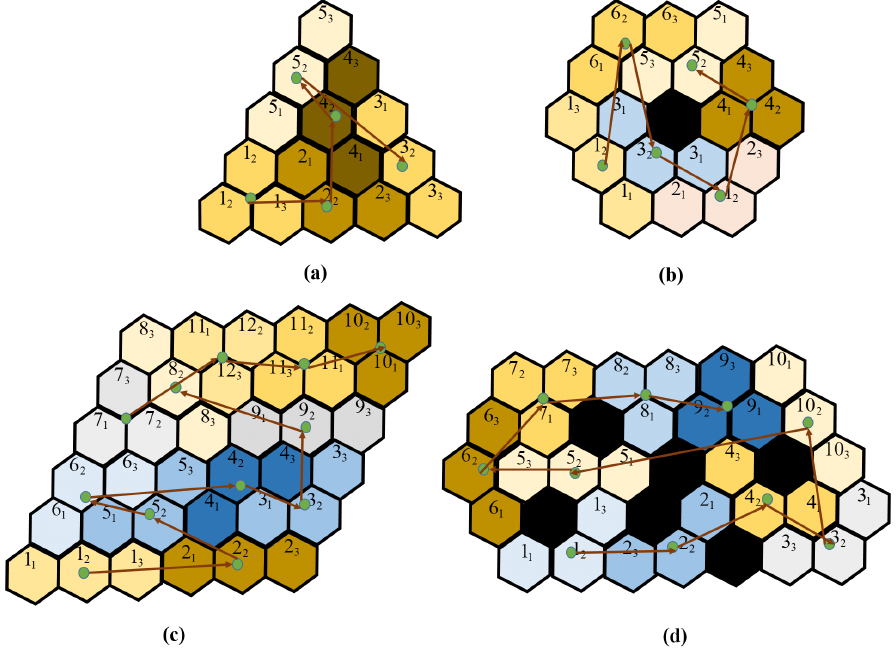
Figure 14. The ACO pareto-optimization trajectories: ( a ) triangle workspace; ( b ) round workspace; ( c ) rhombus workspace; and ( d ) workspace with